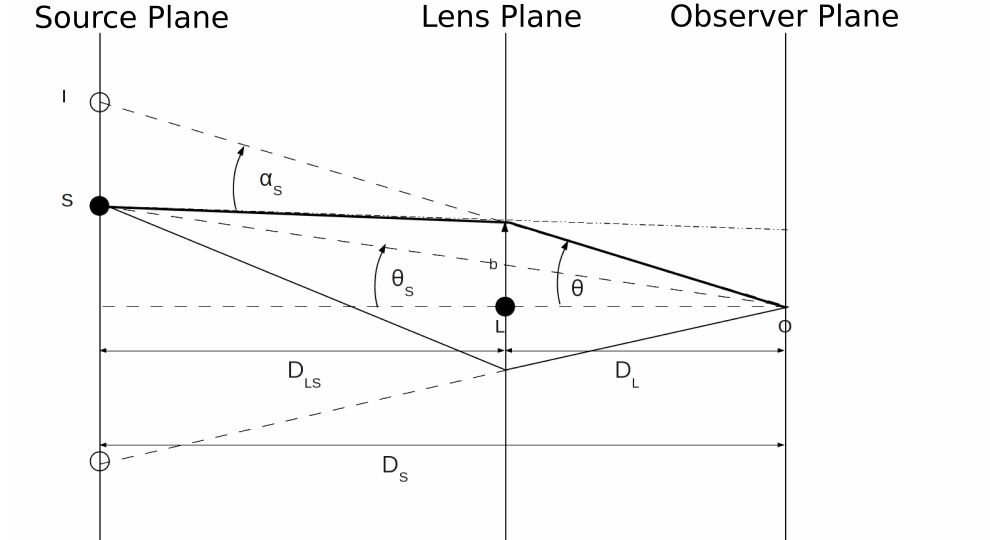
Figure 1. Schematics of the lensing